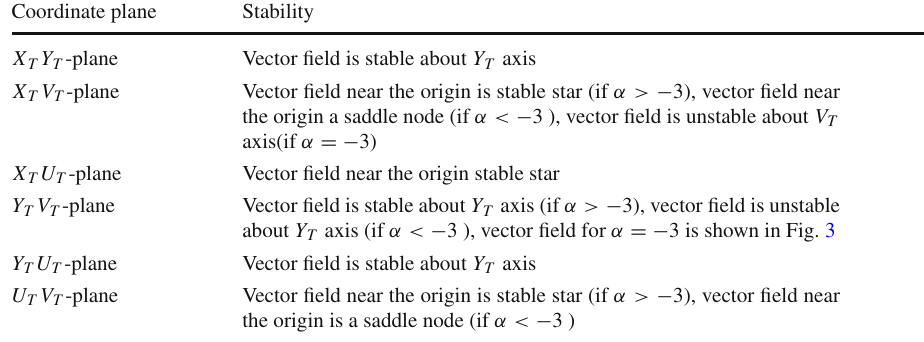
Table 10 Stability of the vector field on every coordinate plane for the critical point B